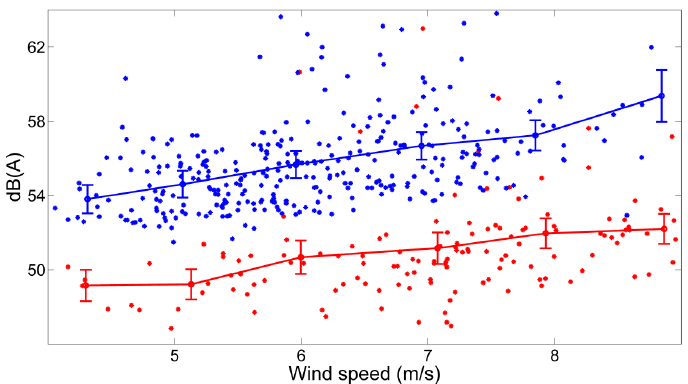
Figure 3. Sound pressure level against wind speed (recalculated to 10 m above ground) presented as an average per 10 s with turbine turned on ( blue ) and off ( red ). The standard uncertainty is plotted for the sound pressure levels for each bin. Table 2. Noise emission for different wind speeds calculated from results of recordings.